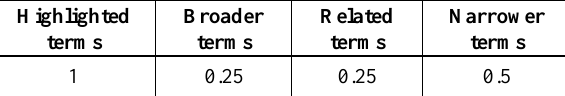
Table 4 | Arrays weights for classifier